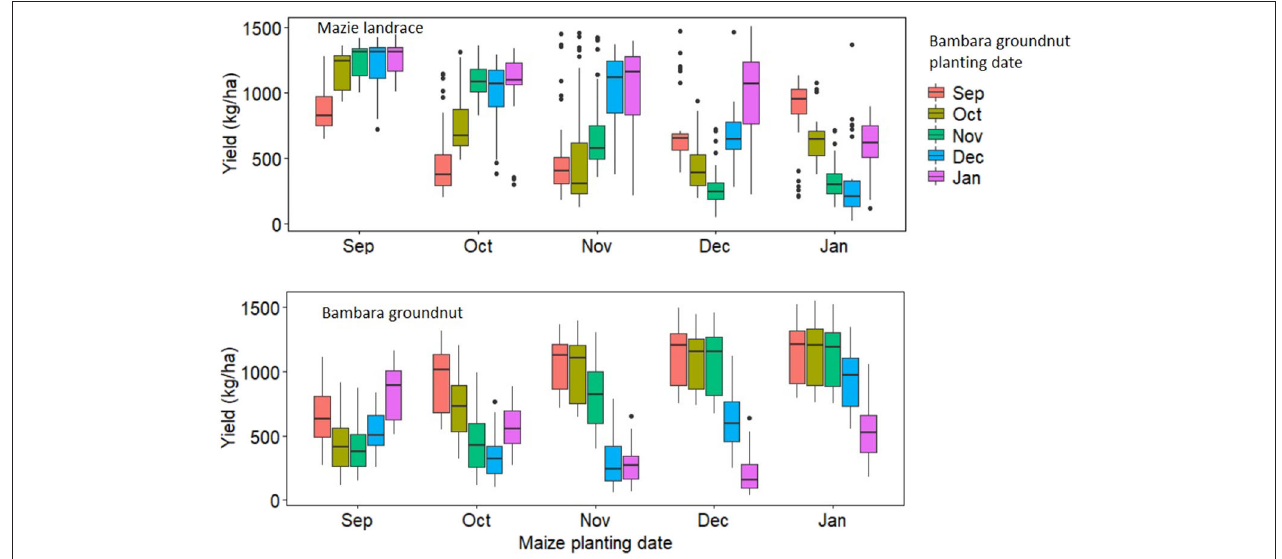
FIGURE 10 | Simulated yield for maize landrace and bambara groundnut across different planting date combinations under rainfed conditions obtained from six GCMs (ACC, CSS, CNR, GFD, NOR, and MPI). The x-axis represents the maize landrace planting dates and the colored boxplots represent the planting date for bambara groundnut. The effect of the interaction between maize landrace planting date and bambara groundnut planting date on maize landrace grain yield - F -statistic: 49.93 on 24 and 875 DF, P = 0.000; The effect of the interaction between maize landrace planting date and bambara groundnut planting date on bambara groundnut grain yield - F -statistic: 75.37 on 24 and 875 DF, P = 0.000.